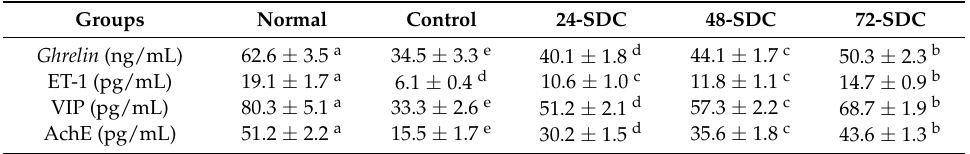
Table 7. Ghrelin , endothelin-1 (ET-1), vasoactive intestinal peptide (VIP), and acetylcholinesterase (AchE) serum levels in mice with diphenoxylate-induced constipation.